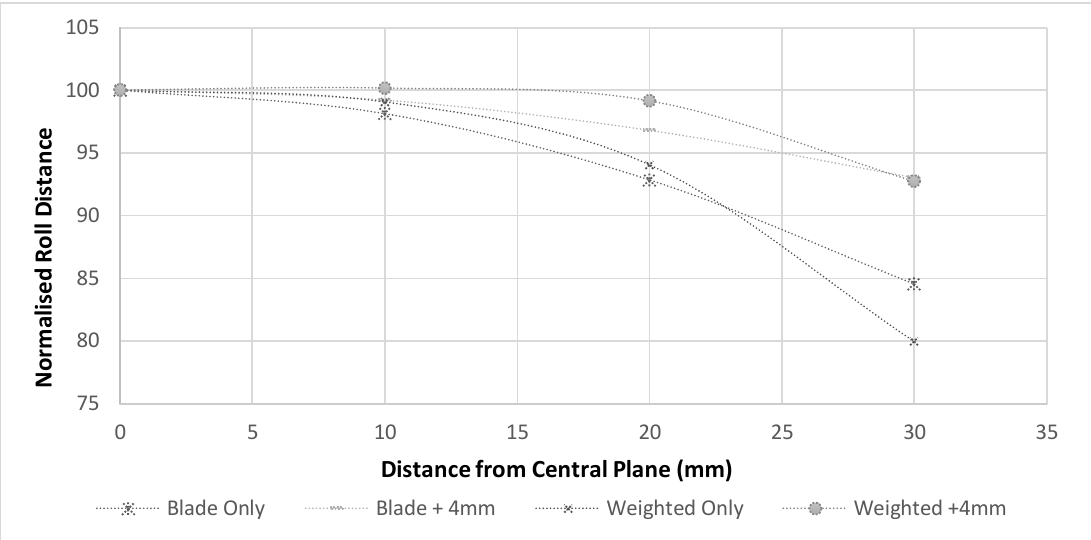
Figure 5. Selected configurations for comparison. In all combinations the flexible face improves roll distance consistency until at least 20 mm from the central